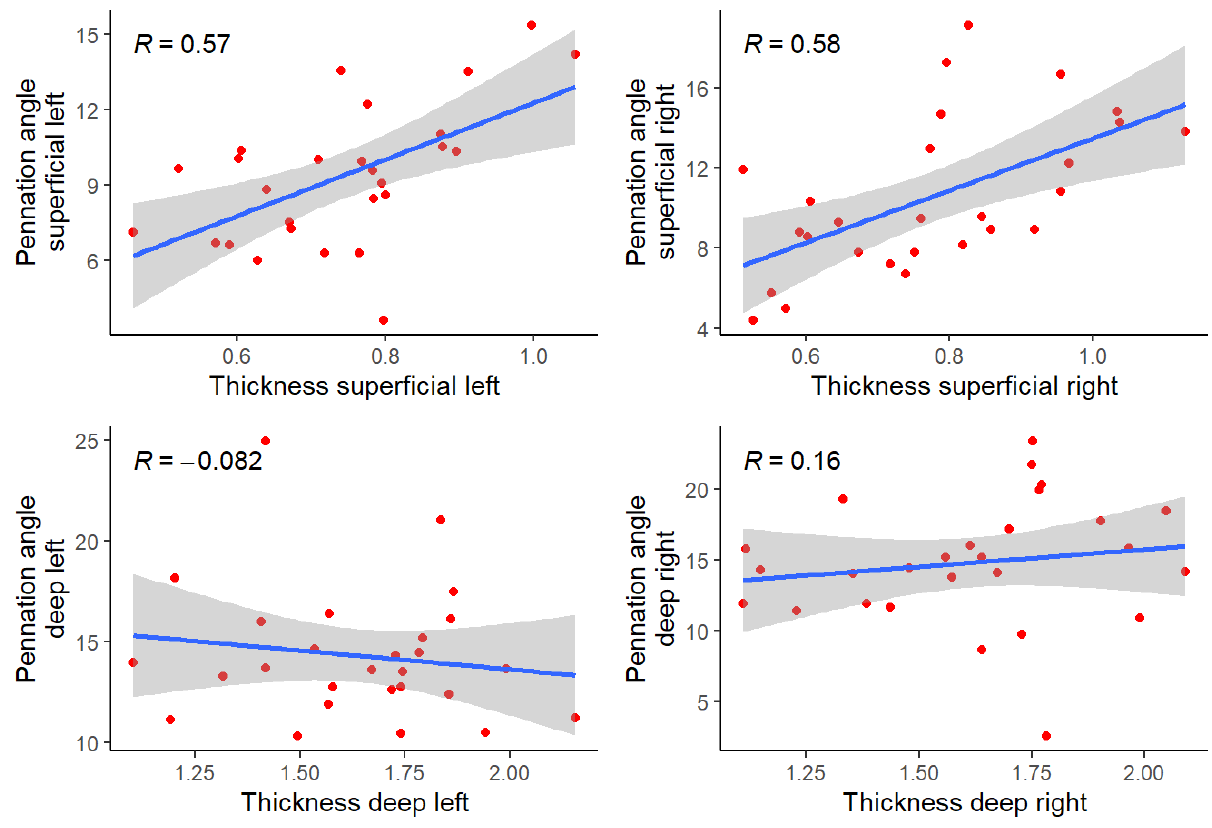
Figure 4. Multifidus thickness vs. pennation angle correlation. R : correlation coefficient.